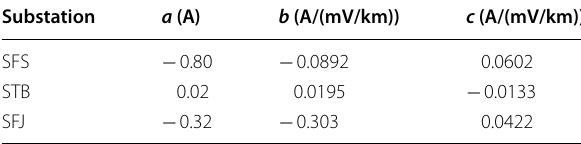
Table 1 Coefficients, a , b and c for the substations SFS, STB,